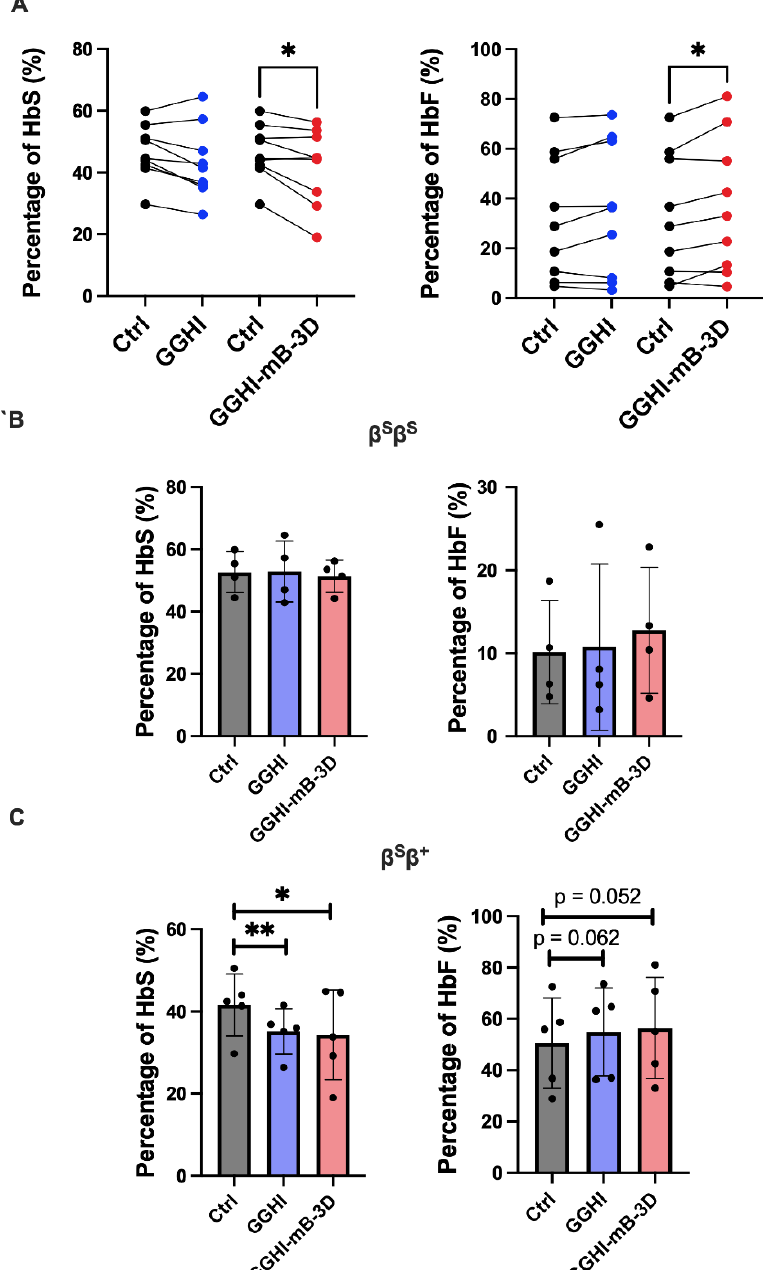
Figure 3. Phenotypic improvement in SCD cells in vitro following transduction with GGHI-mB-3D LV at MOI 100: ( A ) Before-and-after plots showing mean percentage of HbS (left panel) and HbF (right panel) obtained with hemoglobin (Hb) electrophoresis/CE-HPLC across all SCD patients, prior and post transduction, with GGHI ( p = 0.053 and p = 0.091, respectively, n = 9, paired two-tailed t -test) and GGHI-mB-3D ( p = 0.022 and p = 0.023, respectively, n = 9, paired two-tailed t -test) LVs. ( B ) Scatter plots showing mean percentage of HbS (left panel) and HbF (right panel), prior and post transduction, with GGHI ( p = 0.91 and p = 0.79, respectively, n = 4, paired two-tailed t -test) and GGHI-mB-3D ( p = 0.23 and p = 0.33, respectively, n = 4, paired two-tailed t -test) LVs in the β S β S patient cohort. ( C ) Scatter plots showing mean percentage of HbS (left panel) and HbF (right panel), prior and post transduction, with GGHI ( p = 0.005 and p = 0.062, respectively, n = 5, paired two-tailed t -test) and GGHI-mB-3D ( p = 0.03 and p = 0.052, respectively, n = 5, paired two-tailed t -test) LVs in the β S β + patient cohort. Each dot corresponds to each patient. Error bars represent ± SD, * p ≤ 0.05, ** p ≤ 0.01.